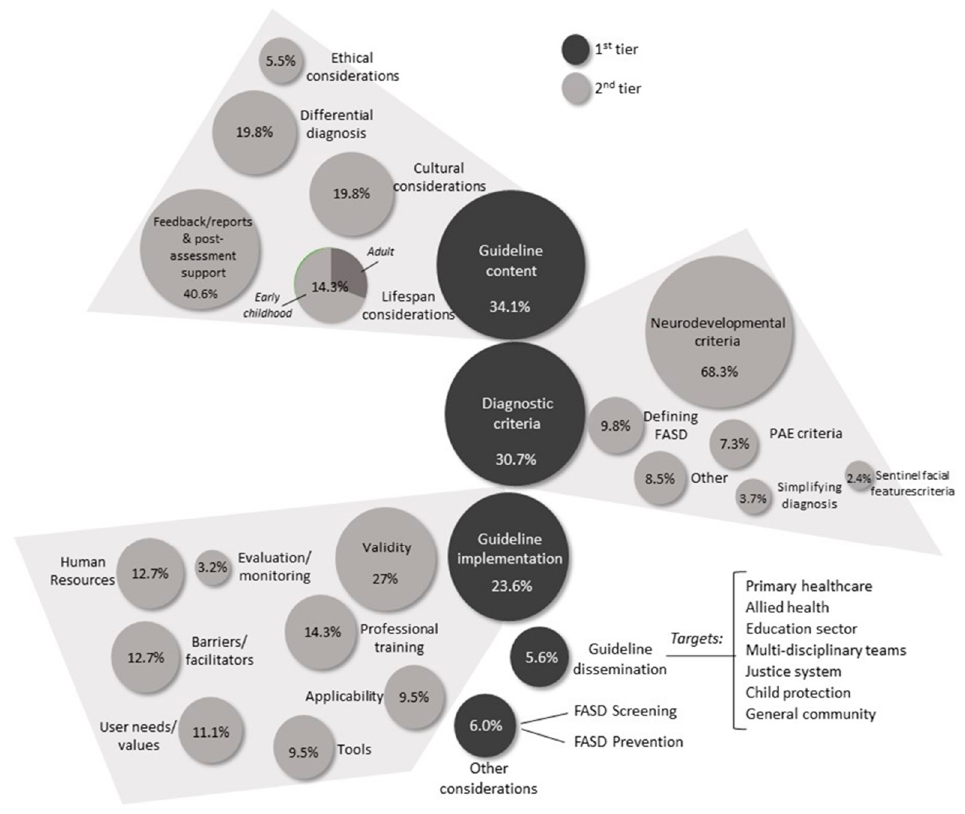
Figure 1. Stakeholder priority areas for the review of the Australian Guide to the Diagnosis of FASD. Table 3. Key stakeholder priorities for the review of the Australian Guide to the Diagnosis of FASD.